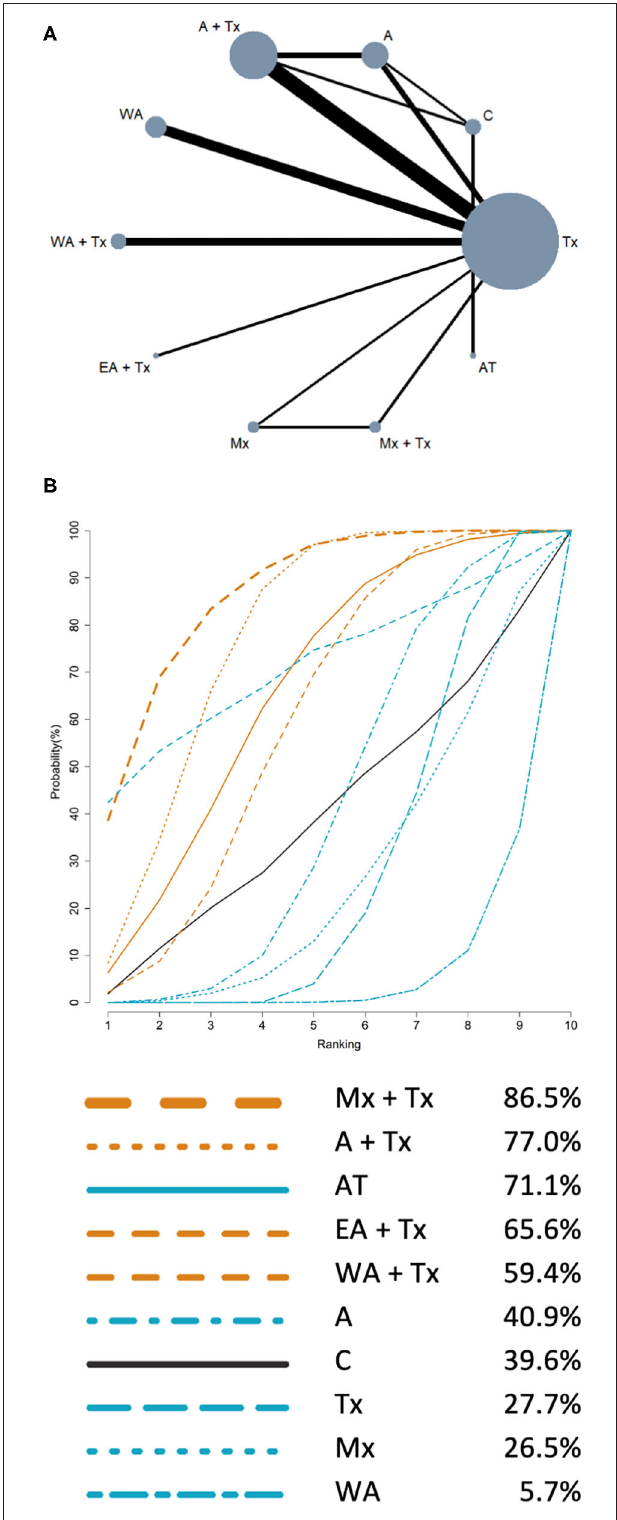
FIGURE 3 | Network meta-analysis results of FEV 1 % predicted: (A) Network plot; (B) SUCRA. (A) Network plot: the size of the nodes corresponds to the number of studies of each treatment. The lines between nodes represent